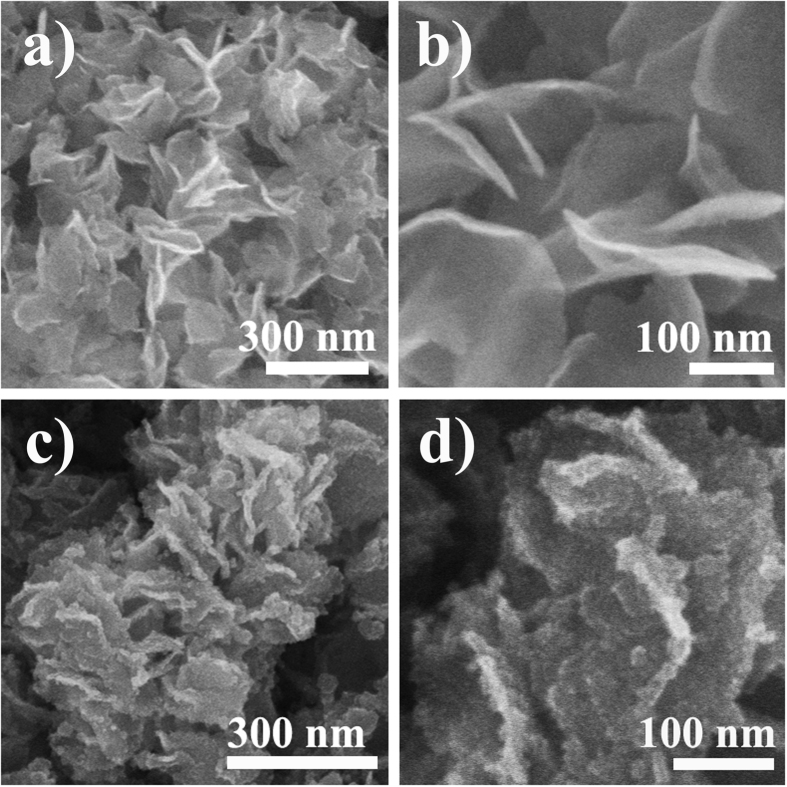
Structrual characterization of MoS2 nanosheets and Fe2O3/MoS2 composite.(a,b) SEM of MoS2 nanosheets, and (c,d) SEM of Fe2O3/MoS2 composite.